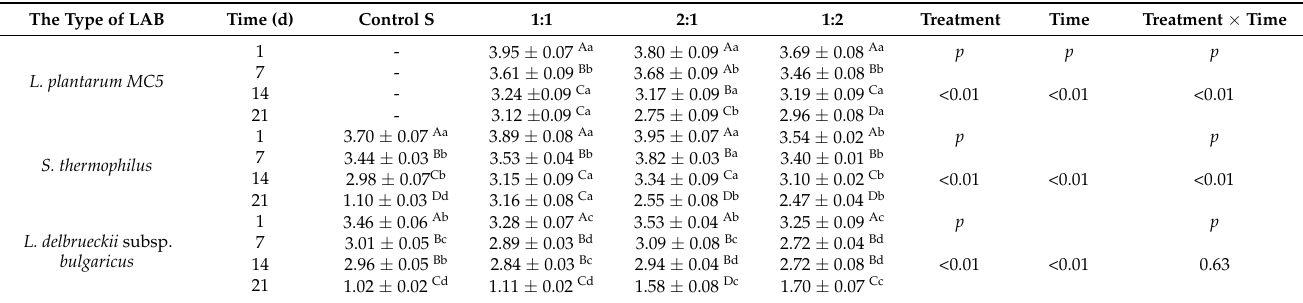
Table 4. Quantities of commercial starters and MC5 survival counts (10 8 CFU/mL) in four groups of yogurt during storage. Data represented as the model-fitted mean ± standard errors. “A, B, C, D” indicate significant differences within yogurt groups in different storage at p < 0.05. “a, b, c, d” indicate significant differences within different strains of the same storage time at p < 0.05.